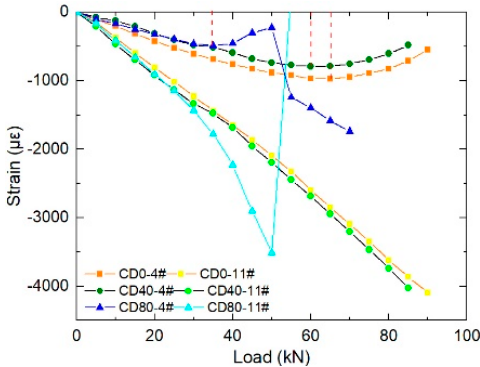
Figure 8. Typical strain-load curves of specimens with different defective.